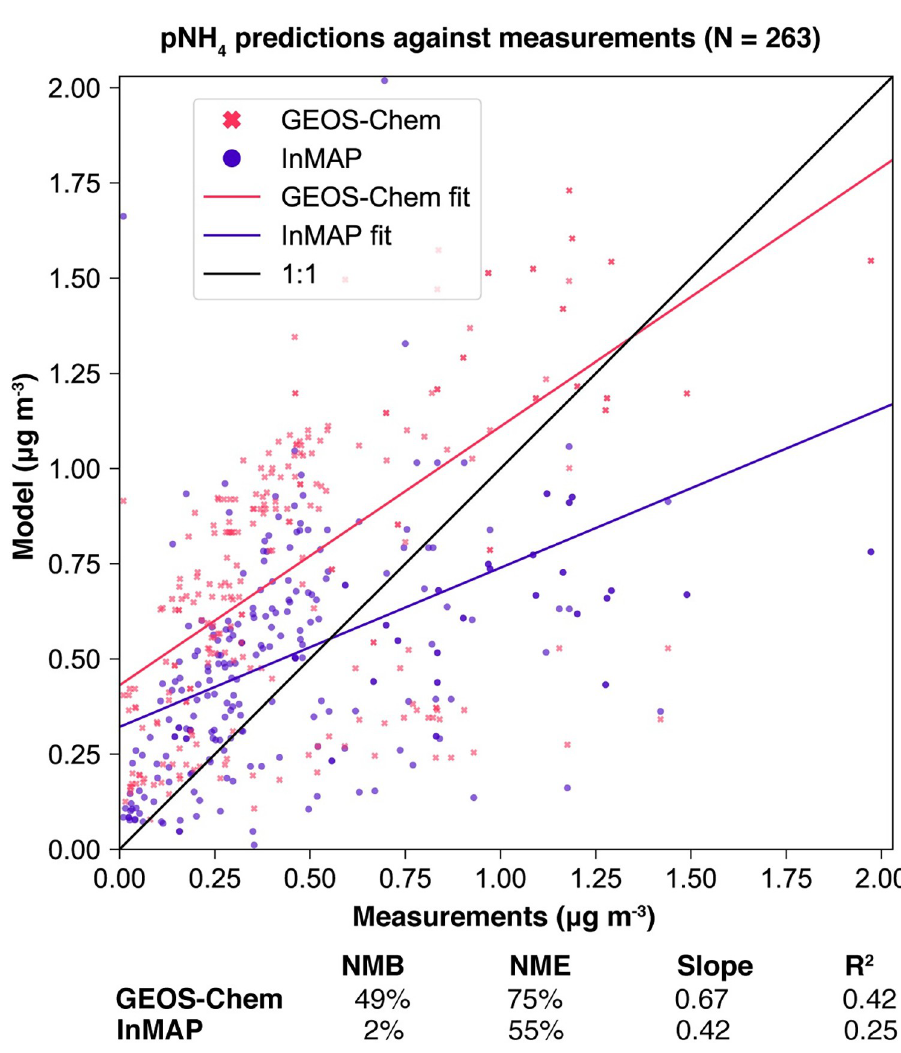
Fig 8. Global InMAP and GEOS-Chem annual-average pNH 4 concentrations against